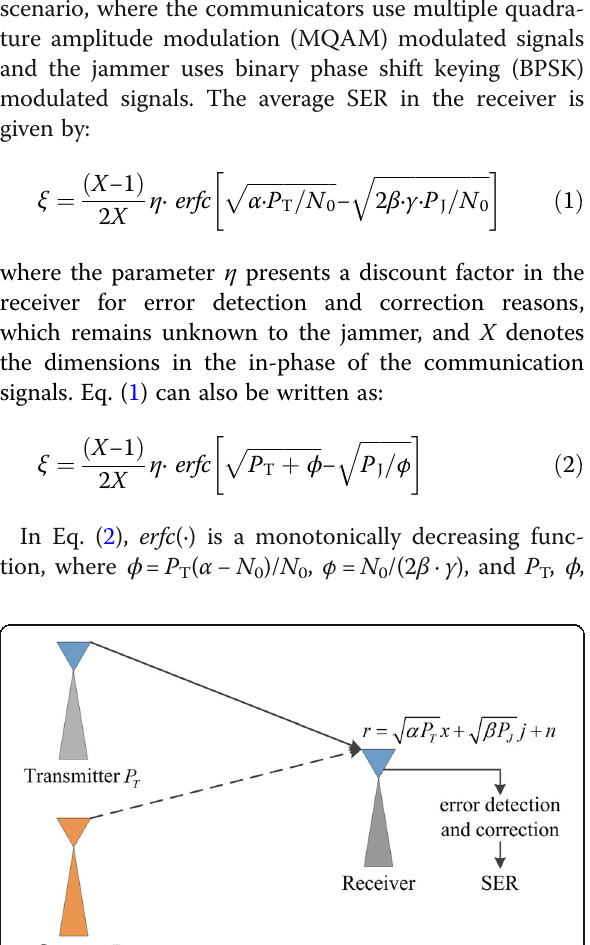
Fig. 1 Real-time jamming environment in wireless